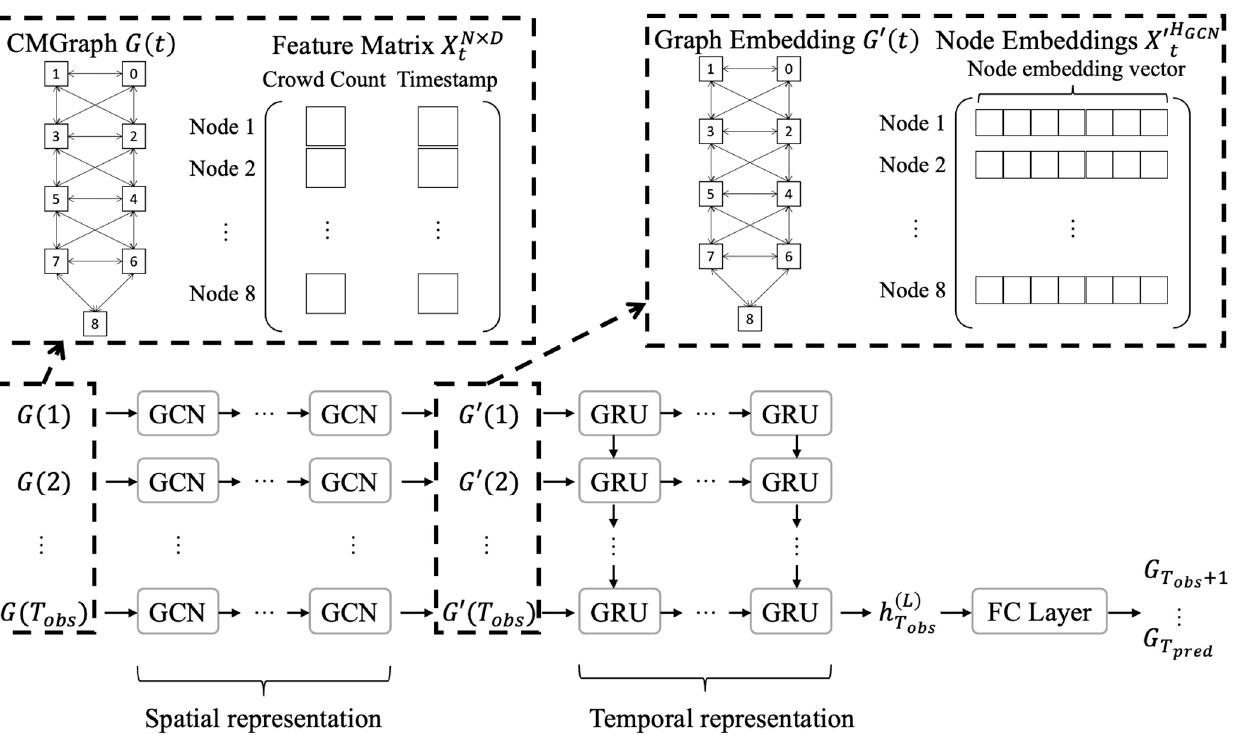
Figure 6. The architecture of the proposed GCN-GRU model.